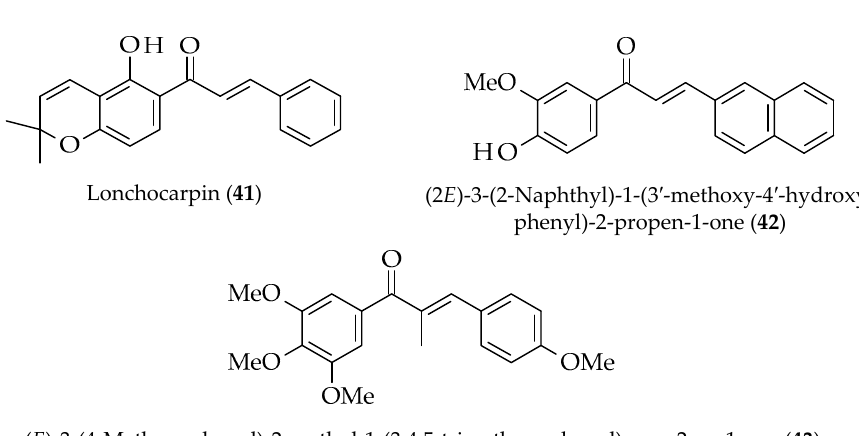
Figure 7. Structures of some chalcones that interfere with the cell cycle.